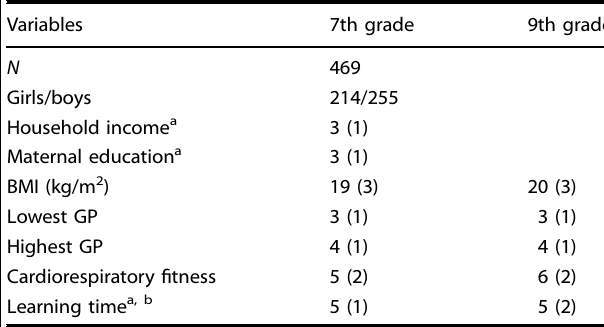
Table 3. Characteristics of study